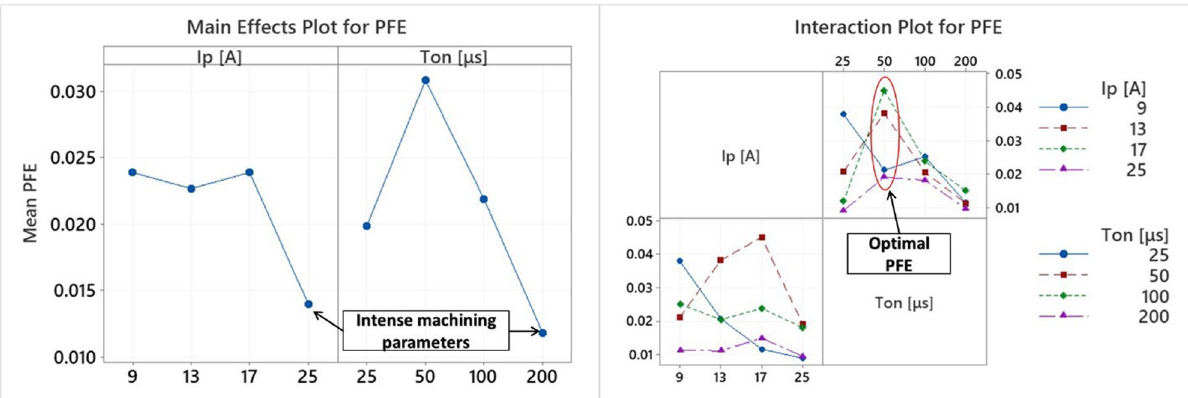
Figure 14. Main effects plot and interaction plot of